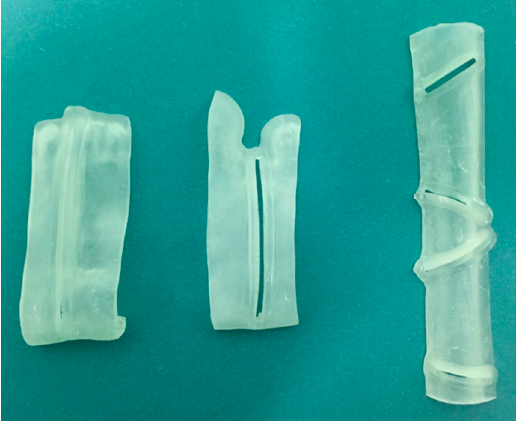
Figure 8. Osteotomy cutting guides.